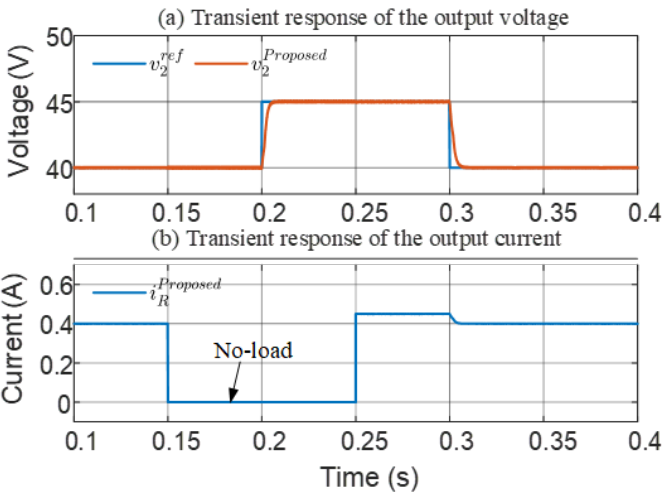
Figure 12. Simulation results of output voltage when the no-load condition is